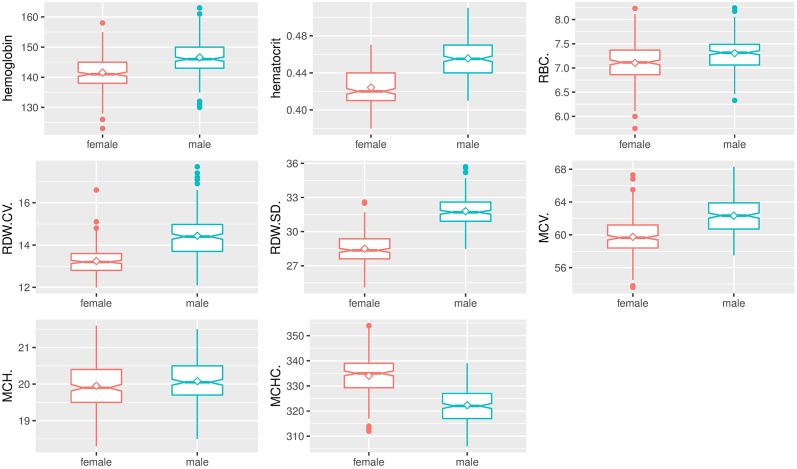
Box and whisker plots show differences in analyte levels of male and female Sprague-Dawley rats on RBC parameters.Data were depicted as box plots that indicated the median, 25th and 75th percentiles (box), mean (◇), and 1.5 times of interquartile (whiskers). Male rats were indicated by a green line, and female rats were indicated by a red line.